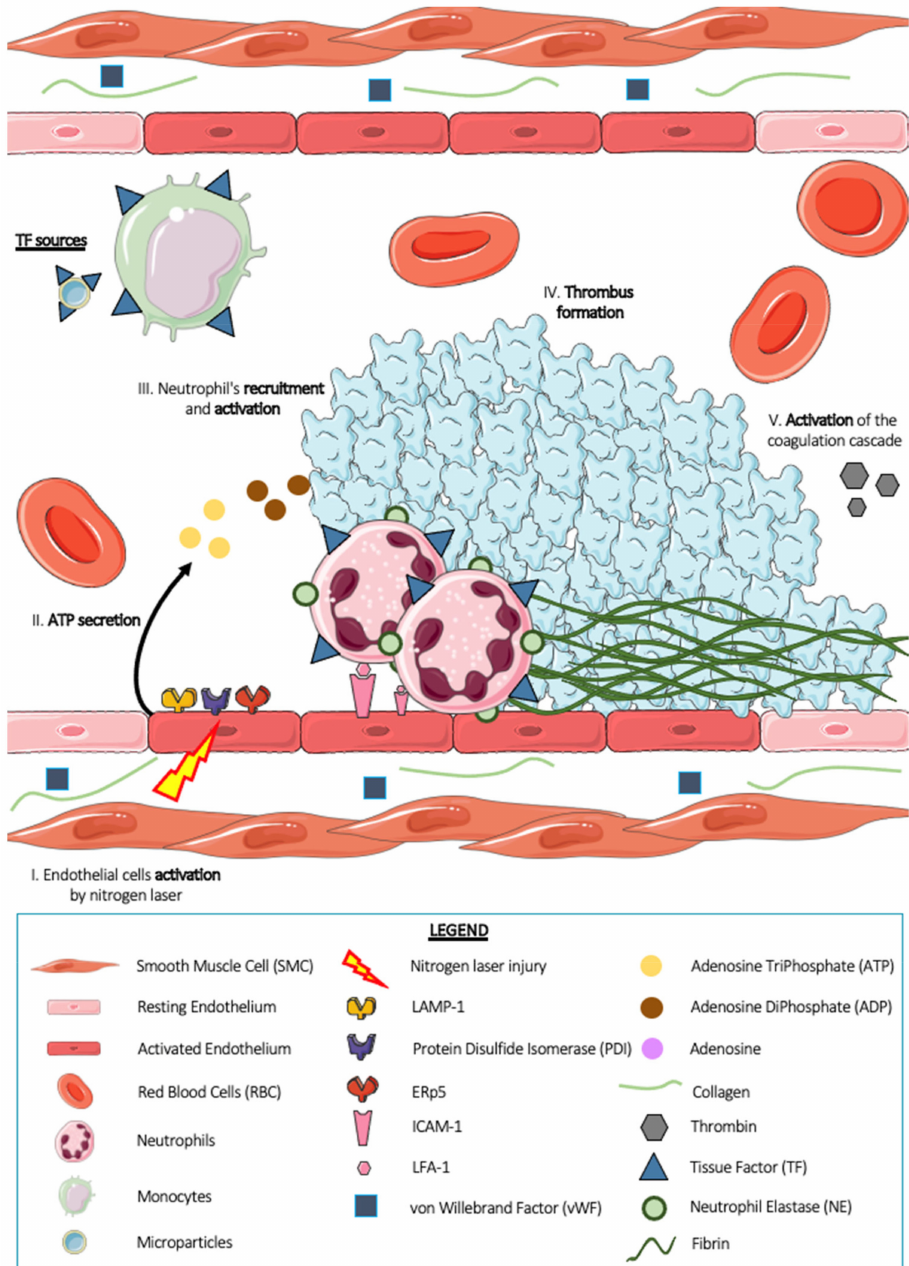
Figure 3. Thrombus formation after a nitrogen laser-induced injury. Platelets, red blood cells, neutrophils, monocytes, microparticles as well as plasma proteins and coagulation factors circulate into the bloodstream. When the endothelium cells are activated by a nitrogen laser beam (I), they secrete adenosine triphosphate (ATP) (II). ATP is a known agonist of neutrophils. It allows their activation and promotes their adhesion to the endothelium (III). Activated neutrophils carry on tissue factor (TF) on their surface responsible for activation and aggregation of platelets. Moreover, platelets secreted adenosine diphosphate (ADP) during their activation, which promotes their aggregation and their accumulation at the site of injury and thus leads to the formation of thrombus (IV). Thrombin, initially present at the site of injury in small quantities which increases with the secretion of active platelets, will induce, together with ATP, ADP, and tissue factor molecules, the activation of the coagulation cascade and the generation of fibrin